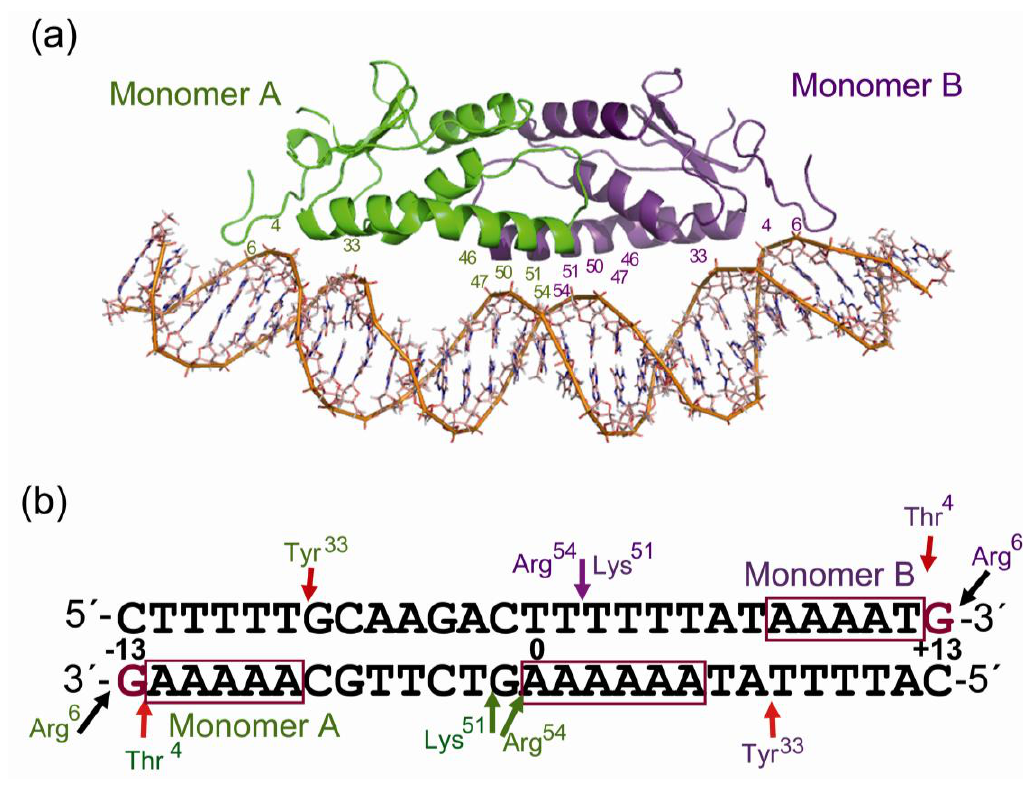
Amino acid interactions with the DNA are marked with